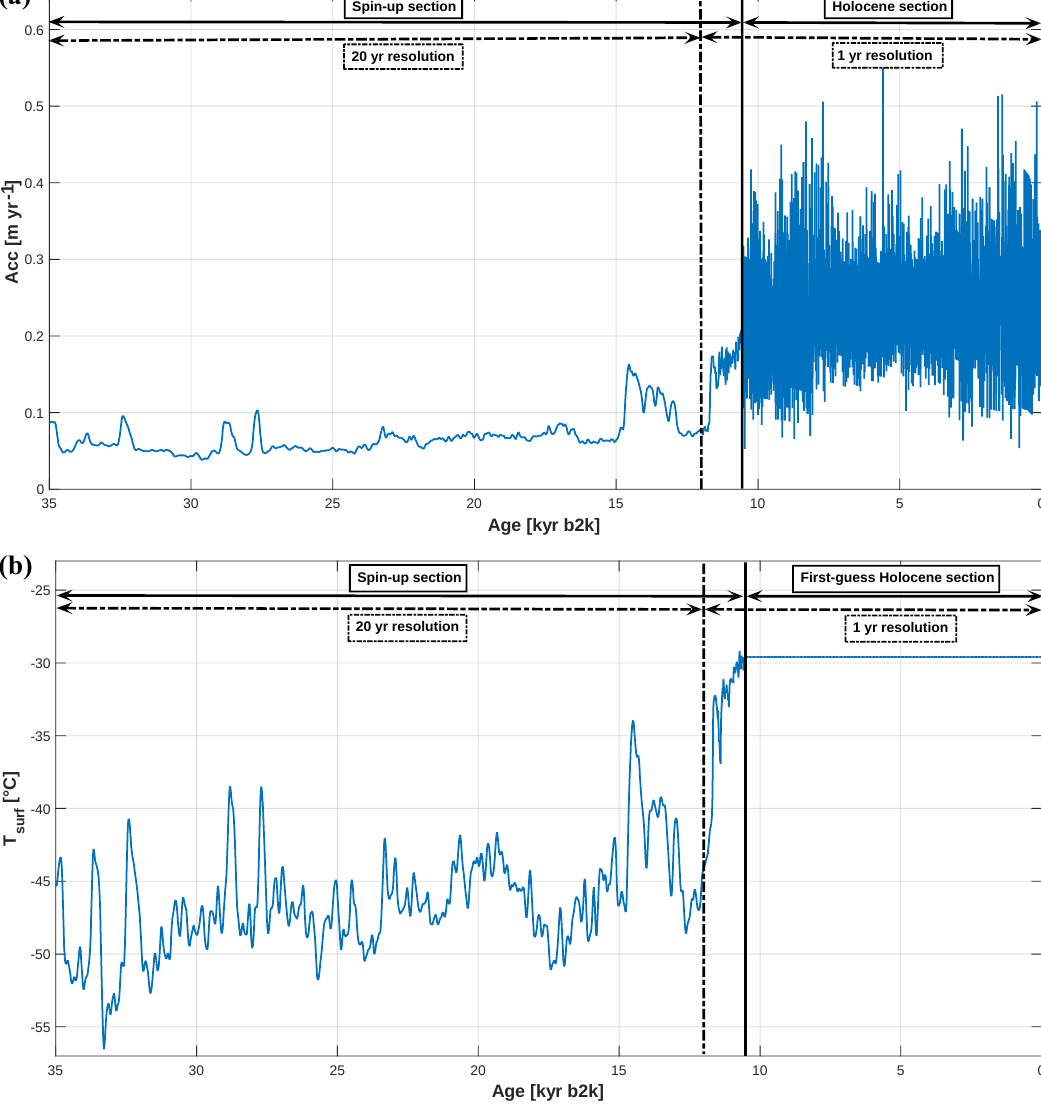
Figure 2. (a) Used accumulation-rate input time series divided in a Holocene and a spin-up section, with time resolution in the Holocene section (20 to 10520 years b2k) of 1 year. The time resolution for the transition between the Holocene and the spin-up section (10520 to 12000 years b2k) is 1 year as well. This is in opposition to the rest of the spin-up section which has a time resolution of 20 years. (b) Surface-temperature spin-up calculated from δ 18 O ice calibration. Time resolution equals the accumulation-rate spin-up section. The first-guess surface temperature input is simply a constant